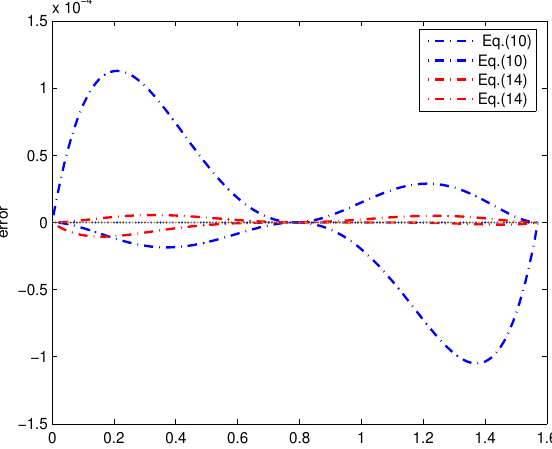
Figure 6. Error plots between sinc(x) and the polynomial bounds of Equations (10) and (14).